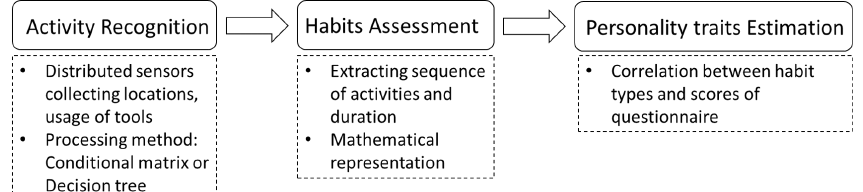
Figure 1. Novel approach to identify personality traits of humans based on their activities. The activity recognition system requires multiple distributed sensors for collecting information on locations and tool usage. Note: this system did not collect video data because of privacy concerns and an energy issue of the system